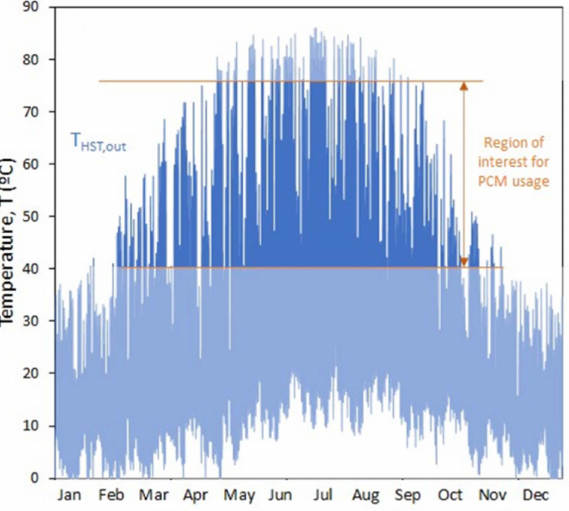
Figure 11. Simulated evolution of the outlet fluid temperature at the HST in the Spanish winery solar plant without using